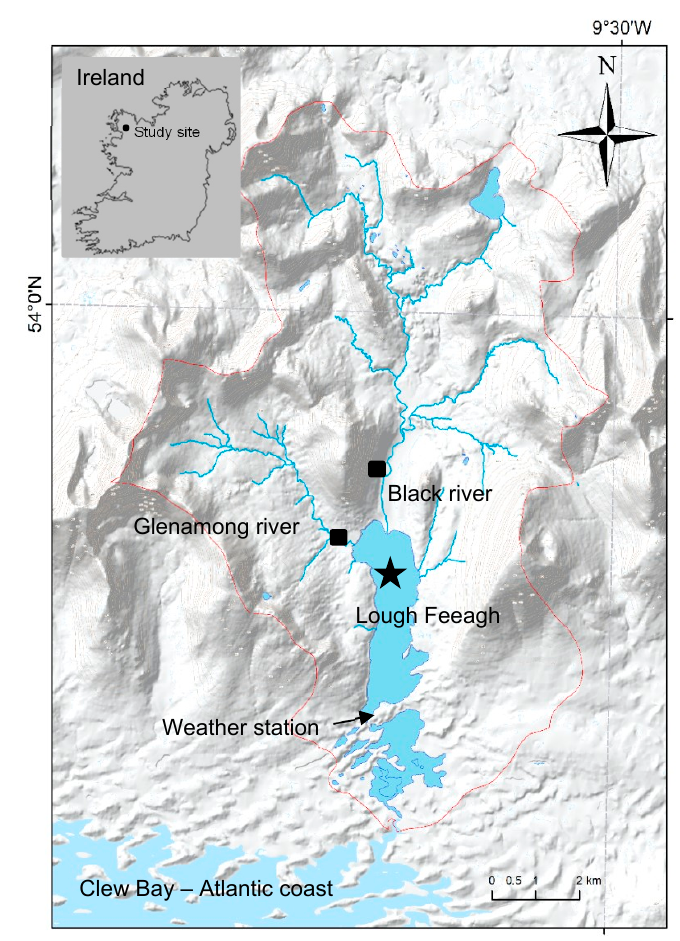
Figure 1. Location of the Burrishoole catchment on the west coast of Ireland. Lough Feeagh is the main freshwater lake and the two main inflow rivers characterise the Glenamong and Black river sub-catchments. The squares represent the Automatic River Monitoring Stations (ARMS) and the star the Automatic Water Quality Monitoring Station (AWQMS). The location of Met Éireann weather station (Newport Furnace) is marked with an arrow.